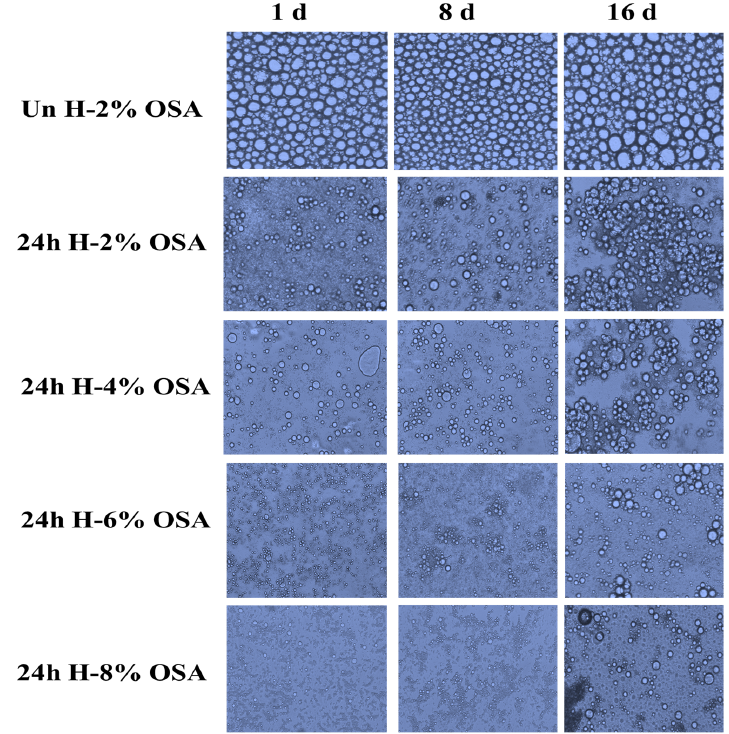
Figure 5. Microstructures of emulsions stabilized by OSA-modified Kudzu starch stored for 1, 8, and 16 d.